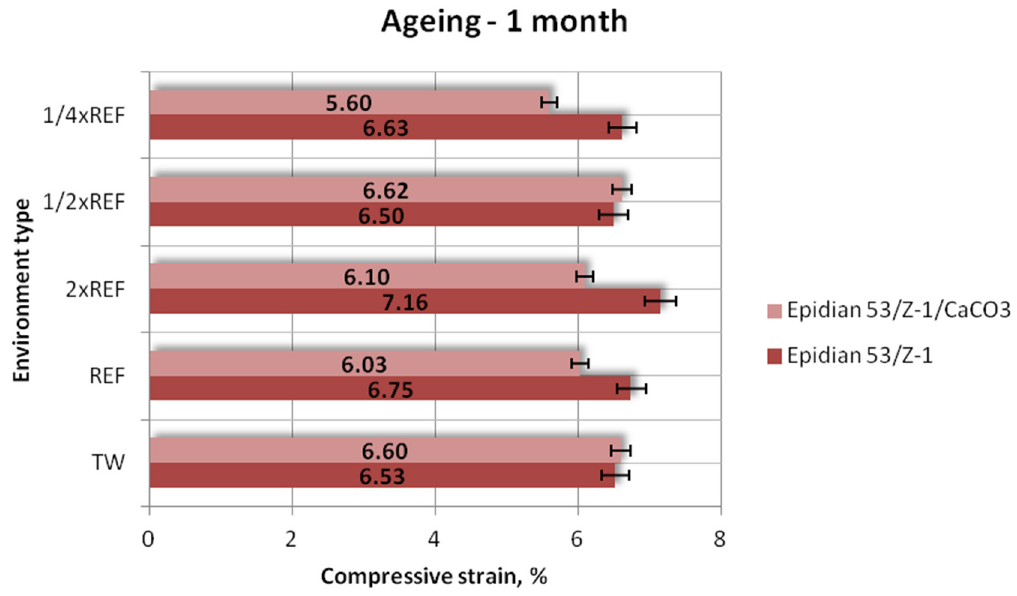
Figure 10. Compressive strain of the unmodified (Epidian 53 / Z-1) and modified (Epidian 53 / Z-1 / CaCO 3 ) epoxy adhesive compounds, aged for 1 month.